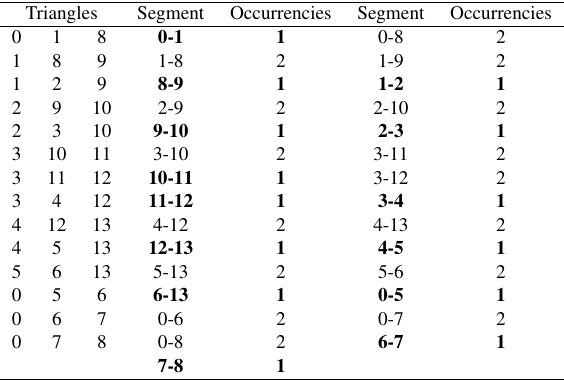
Table 2: The segments of the 2D point cloud illustrated in Figure 9: the points belonging to the border of the polygon are those which appear only once.